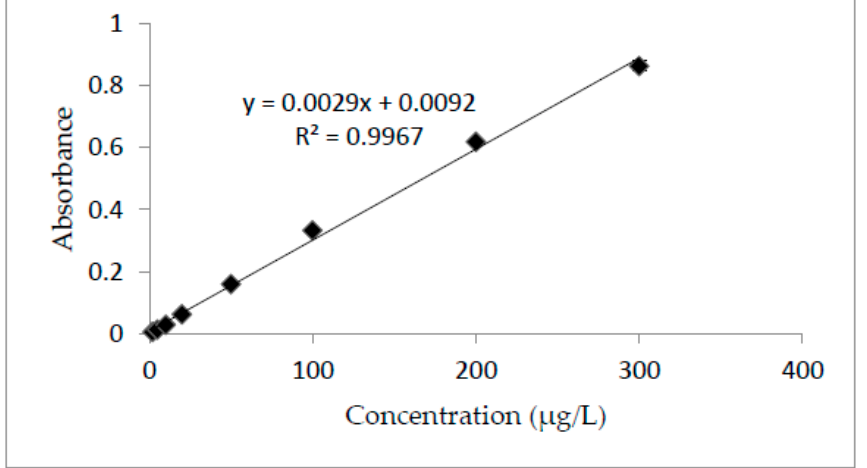
Figure 3. Calibration curve. Analyte concentration-2–300 µg/L; buffer volume-2 mL (pH = 6); sample volume-20 mL; DES volume-500 µL; THF volume-300 µL; temperature-25 °C; sonication time-2 min; centrifugation time-1 min.